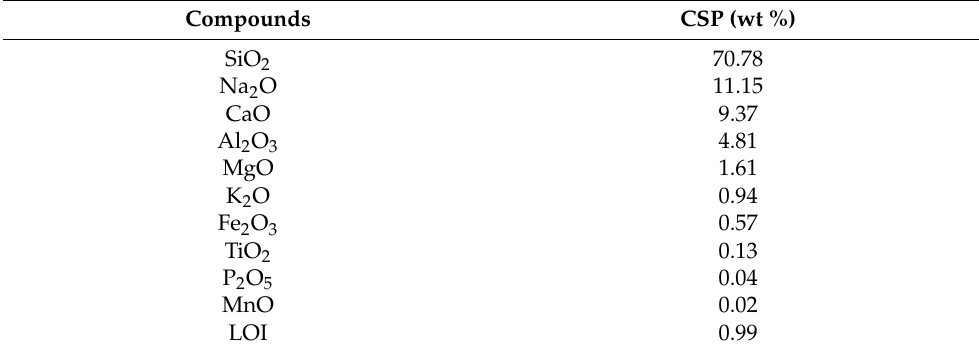
Table 2. X-ray fluorescence (XRF) results from the CSP raw